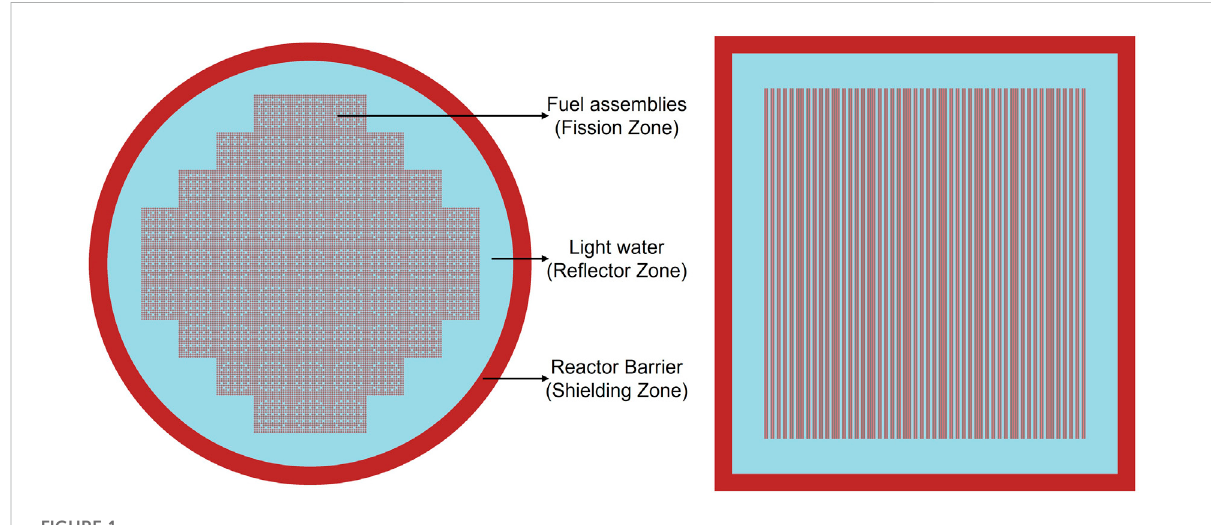
FIGURE 1 Radial and axial view of the OpenMC SMART core.